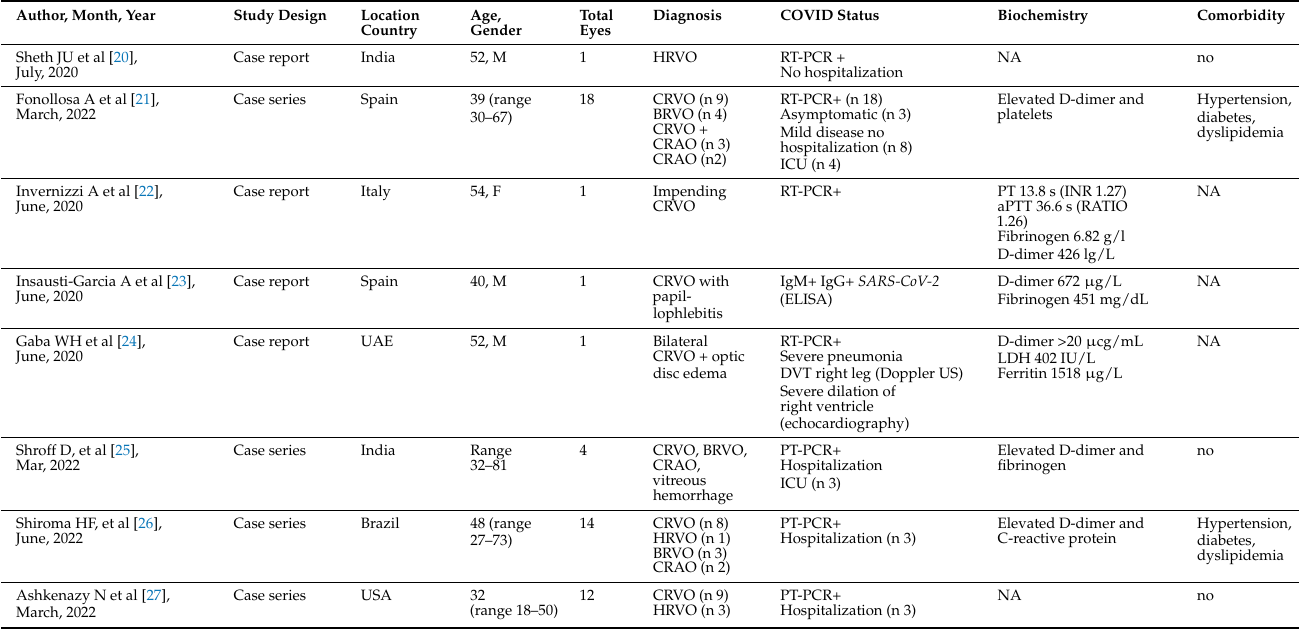
Table 2. Demographic and clinical manifestations of patients with retinal vein